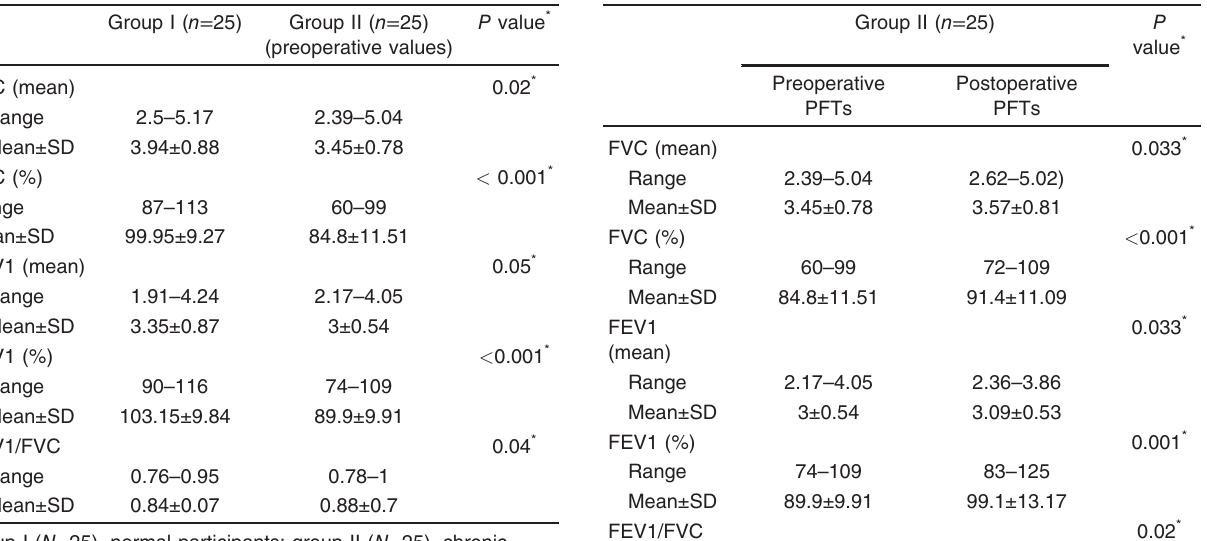
Table 4 Pulmonary function tests values: group II (preoperative vs. postoperative)